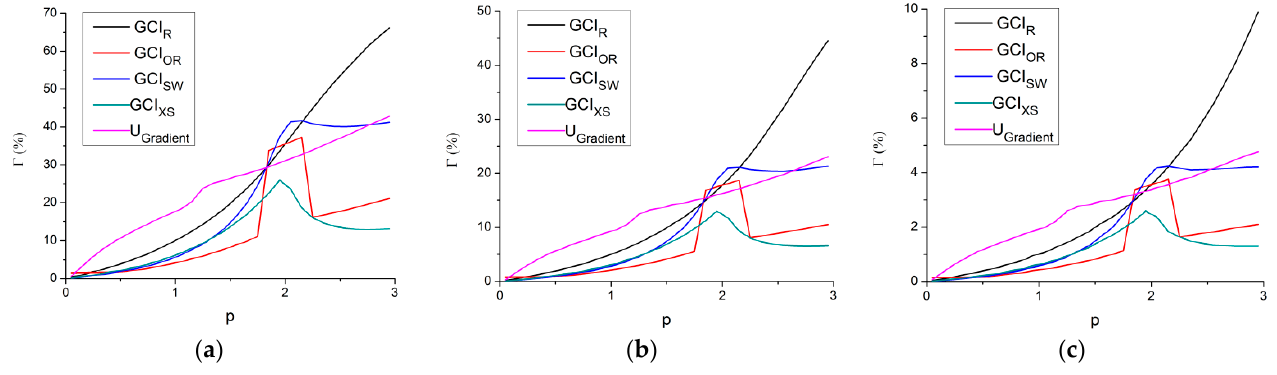
Figure 6. The result of a random data test: ( a ) U Target = 10%; ( b ) U Target = 5%; ( c ) U Target = 1%.